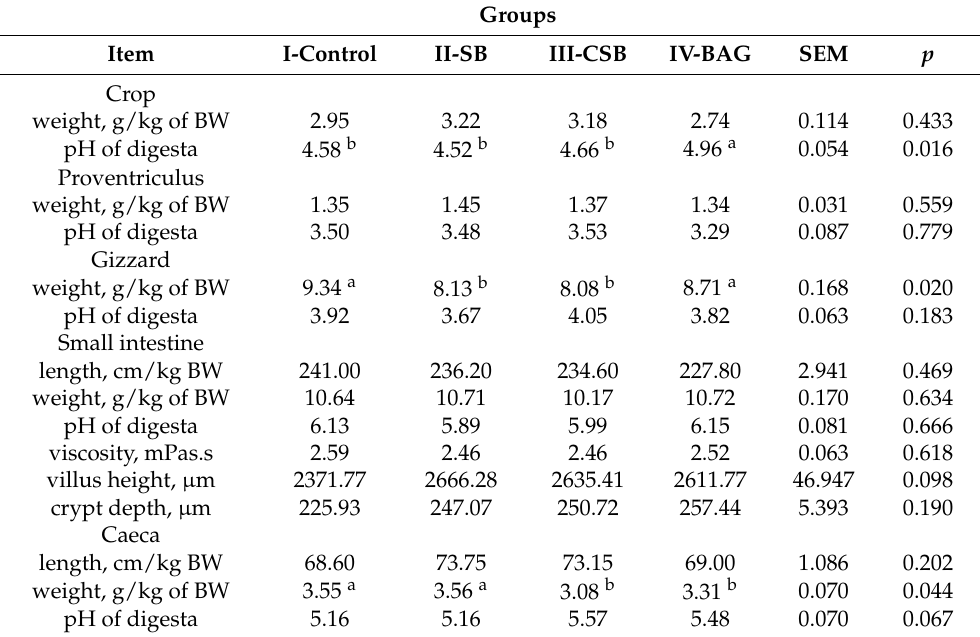
Table 5. Gastrointestinal parameters in 15-week-old